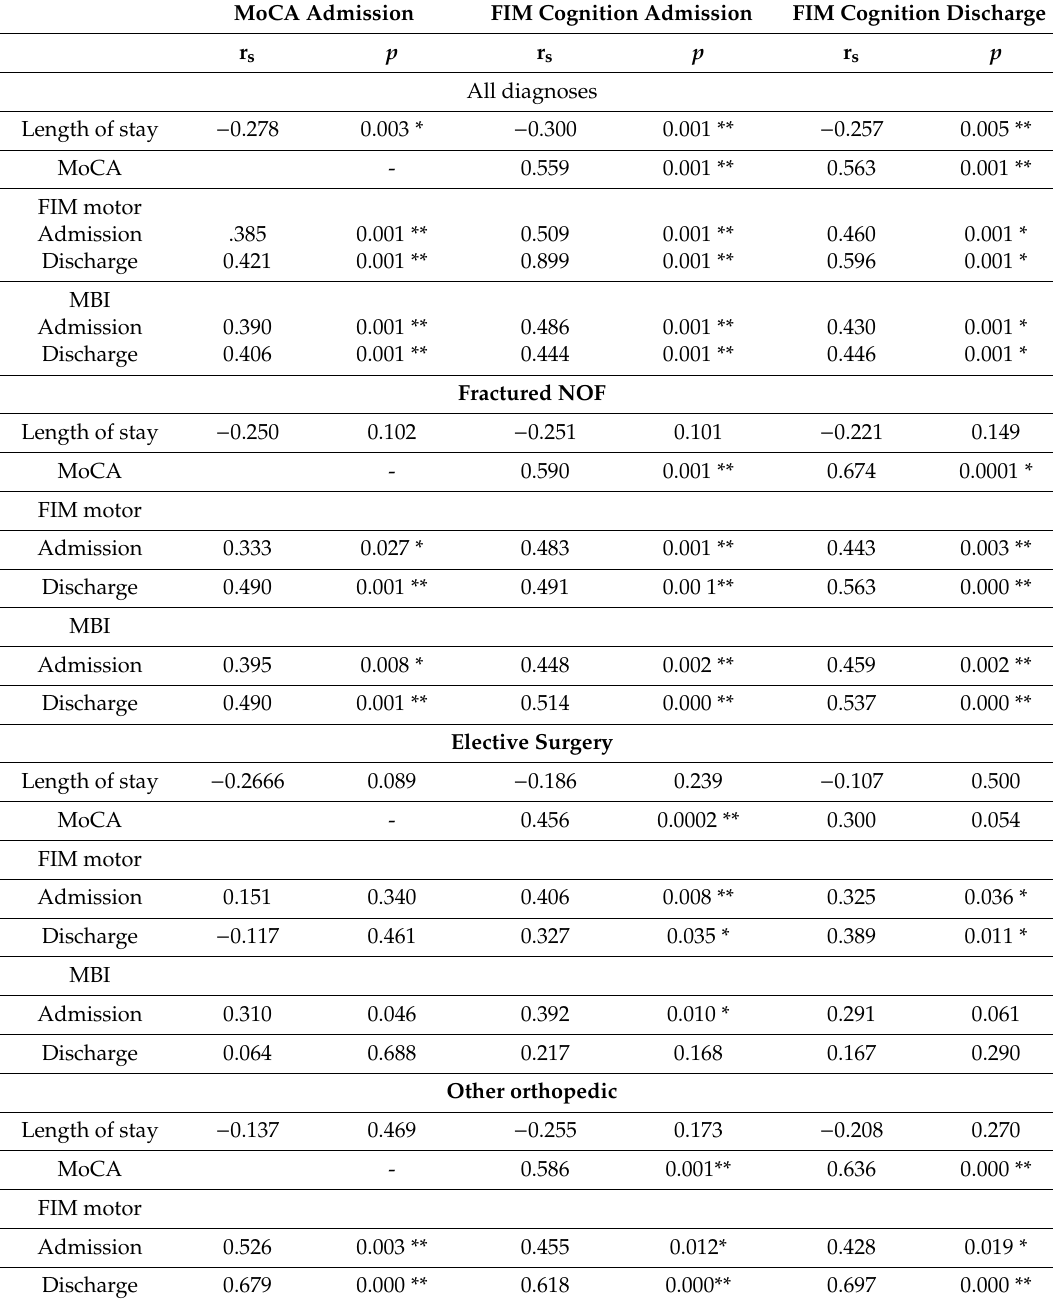
Refer to Table 3, for all associations between MoCA / FIM cognitive scores and functional outcomes. Length of stay was found to be significantly associated with diagnoses grouping. Post hoc analysis demonstrated a significant di ff erence between the fractured NOF (median = 27) and orthopedic other (median = 31.5) group with a significantly longer length of stay, when compared to patients with elective orthopedic surgery (median = 13) ( p < 0.001). Table 3. Association between MoCA / FIM cognitive scores and functional